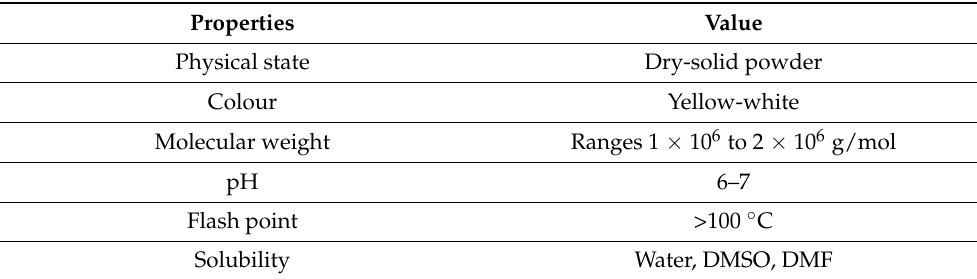
Table 1. Physicochemical properties of Xanthan